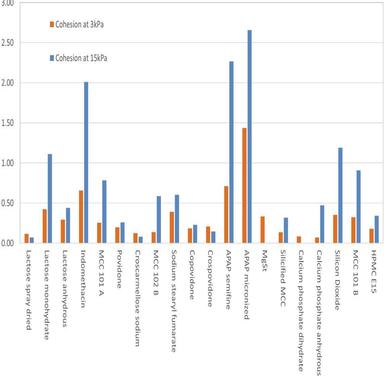
Cohesion results from shear cell test at a consolidation stress of 3 kPa and 15 kPa.